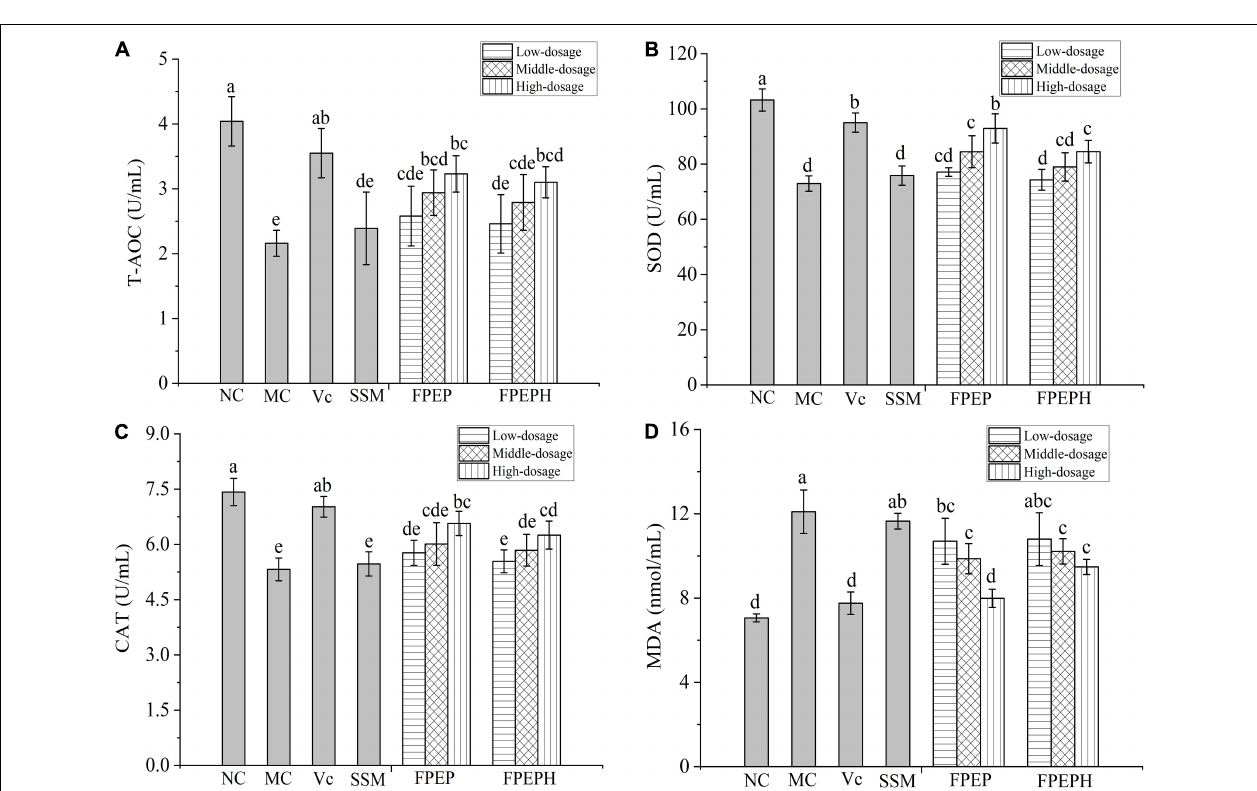
FIGURE 5 | Effects of sour soybean milk on improving antioxidant activity of mice. (A) T-AOC, (B) SOD, (C) CAT, and (D) MDA. Data were presented as the Mean ± S.D. The same letters indicated no significant differences and different letters indicated significant differences at P < 0.05. NC: control group; MC: model group; Vc: vitamin C-ascorbic acid; SSM: sour soybean milk; FPEP: fermented with P. eryngii polypeptides with a molecular weight of < 3 kDa; FPEPH: fermented with P. eryngii protein hydrolysate; CAT: catalase; MDA: malondialdehyde; SOD: superoxide dismutase; T-AOC: total antioxidant capacity.